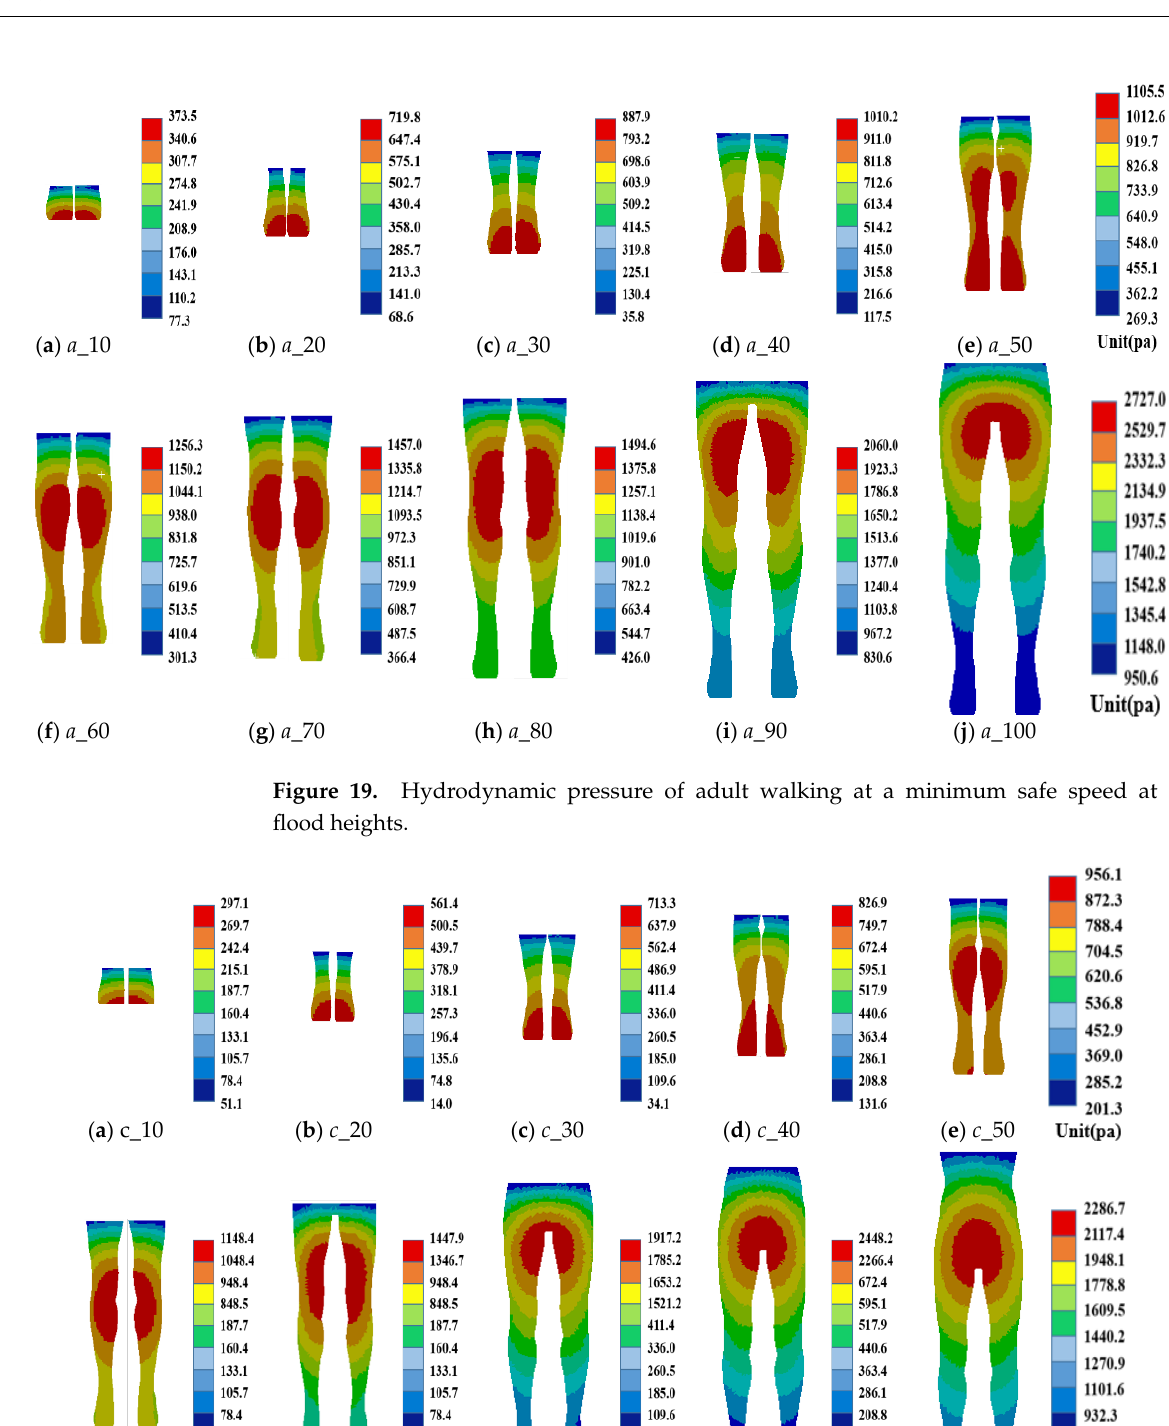
( j ) e _100 Figure 21. Hydrodynamic pressure of elder walking at a minimum safe speed at different flood heights. Table 9. Flood resistance of all groups walking at a critical speed at different flood heights. Flood Height (cm)